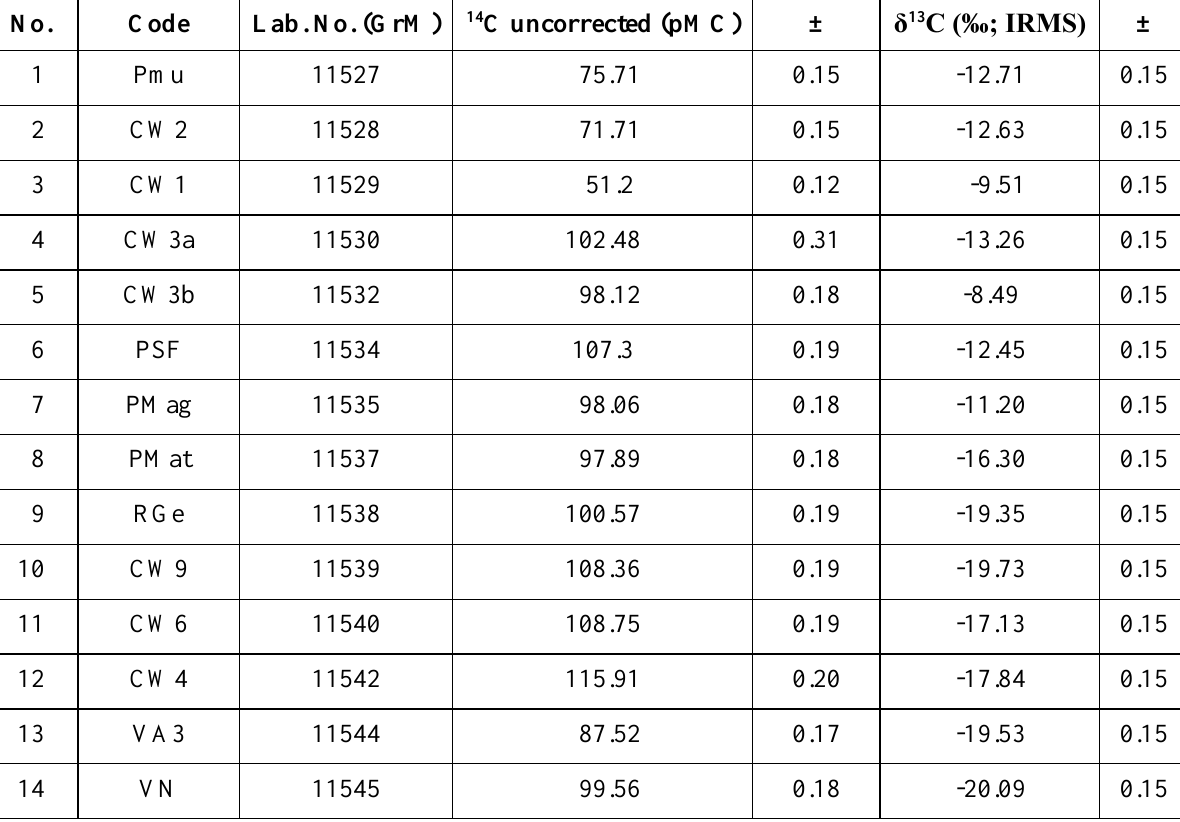
Table 2. 14 C dating of 14 groundwater samples in the northern part of the Maputaland Coastal